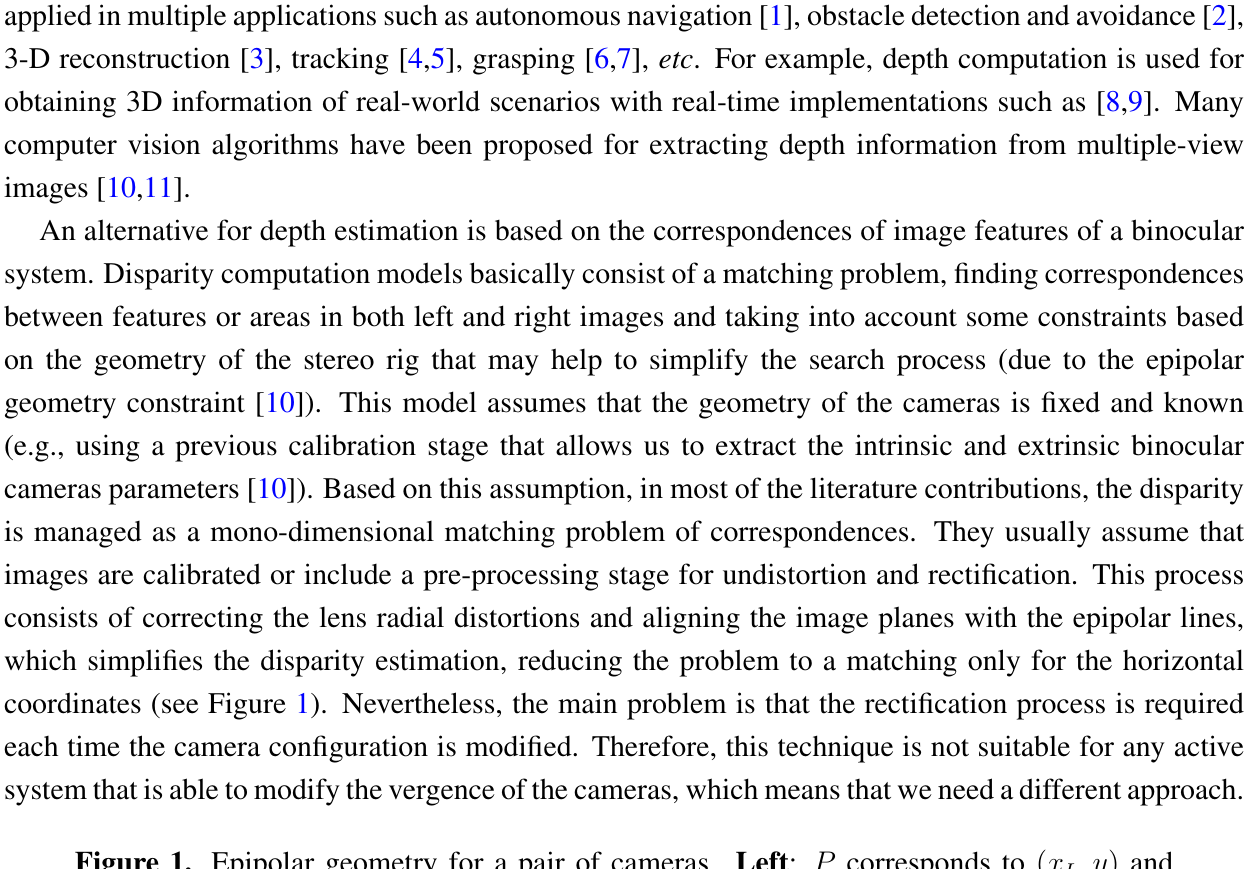
, y ) and L and Ep are L R and E stand for R L